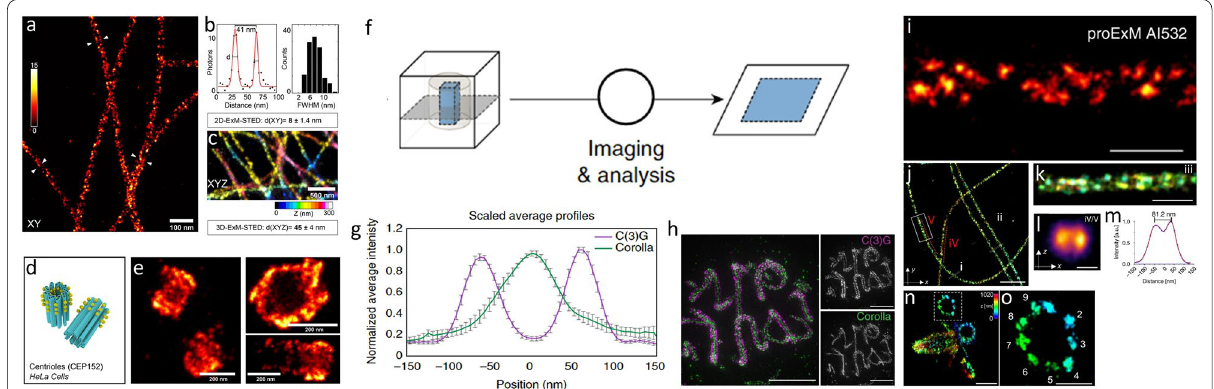
Fig. 16 Combining ExM and super-resolution microscopy methods. a – e Expansion STED (ExSTED). a Magnified view of the microtubules, showing clear distinction of the antibody positions on the opposing sites of a single microtubule. Scale bar, 100 nm. b Quantification of the apparent diameter of microtubule and the 2D resolution. c 3D STED of the expanded microtubules using an oil objective. Scale bar, 500 nm. d Model of the centrioles (blue) and the centriole-associated protein CEP152. e ExSTED HeLa cells with CEP152 staining. Scale bar, 200 nm. f – h Expansion SIM (ExSIM). f Sectioning of the expanded sample. g Z-projection of the reconstructed SIM image. h By matching the RI of the immersion oil with the sample, fine details of the Drosophila SC structure can be analyzed. Scale bars, 5 μm. i – o Expansion SMLM (ExSMLM). i dSTORM image of pre-labeled, proExM-expanded and re-embedded Cos-7 cells stained with primary antibodies against α-tubulin and Alexa Fluor 532-conjugated secondary antibodies. Scale bar, 500 nm. j 3D dSTORM image of the expanded and re-embedded Cos-7 cells labeled with anti α- and β-tubulin antibodies and additionally post-labeling with anti-α-tubulin. Scale bar, 5 μm. k Magnified view of highlighted region (white box) in j . Scale bar, 500 nm. l Image projection of the xz-axes averaged along two microtubule filaments shown in j . Scale bar, 100 nm. m Cross-sectional profile (blue dots) of the xz-projection shown in l . Using a bi-Gaussian fit (red), the peak-to-peak distance is determined to 81.2 nm. n , o 3D dSTORM image of U-ExM expanded and re-embedded Chlamydomonas centrioles stained post re-embedding. Zoom-in image of the boxed area in n is shown in o . Scale bar, 1 μm ( n ), 500 nm ( o ). ( a – e ) Reprinted/adapted with permission from Gao et al. [97]. Copyright 2018 American Chemical Society. f – h Reprinted/adapted by permission from Springer Nature: Wang et al. [99], copyright 2018. i – o Reprinted/adapted from Zwettler et al.